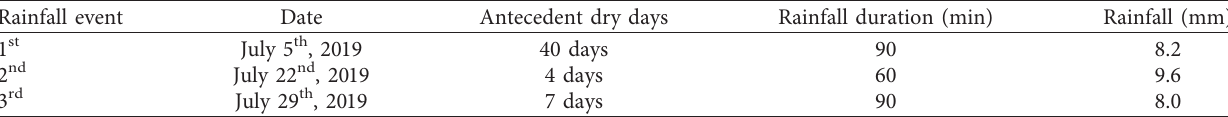
Table 2: Character of rainfall events at sampling